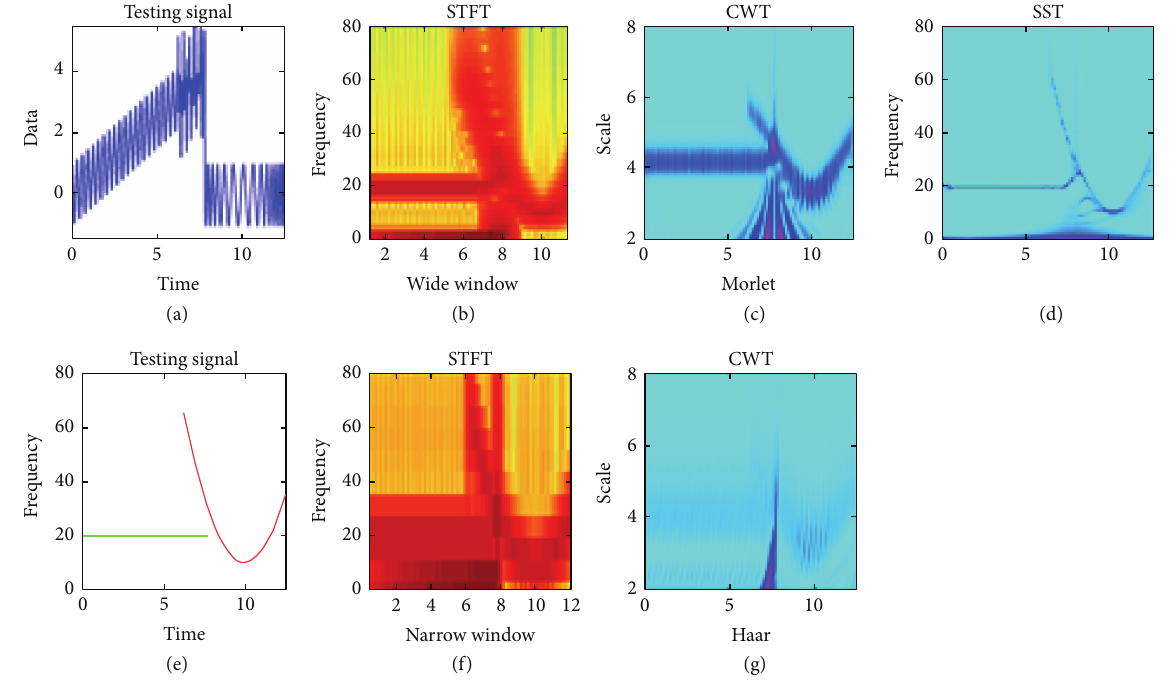
Figure 10: Time-frequency analysis. The testing signal (upper left corner) is composed of two kinds of oscillations (constant and variant) with a sharp transition in between. Its ideal spectral representation is shown on the lower left corner. Due to their limited time-frequency resolution, the sharp transition induces blurring in the time-frequency representation of STFT and CWT whatever the window size and the mother wavelet, respectively. On the contrary, the SST approach is still able to correctly follow the instantaneous variations in frequency. Modified from